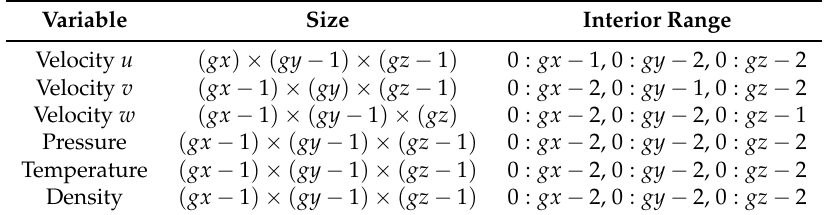
Table 1. Sizes and computational ranges of variable layouts on domain Ω = [ gx × gy × gz ] where gx , gy , gz are the total grid dimensions in each direction.